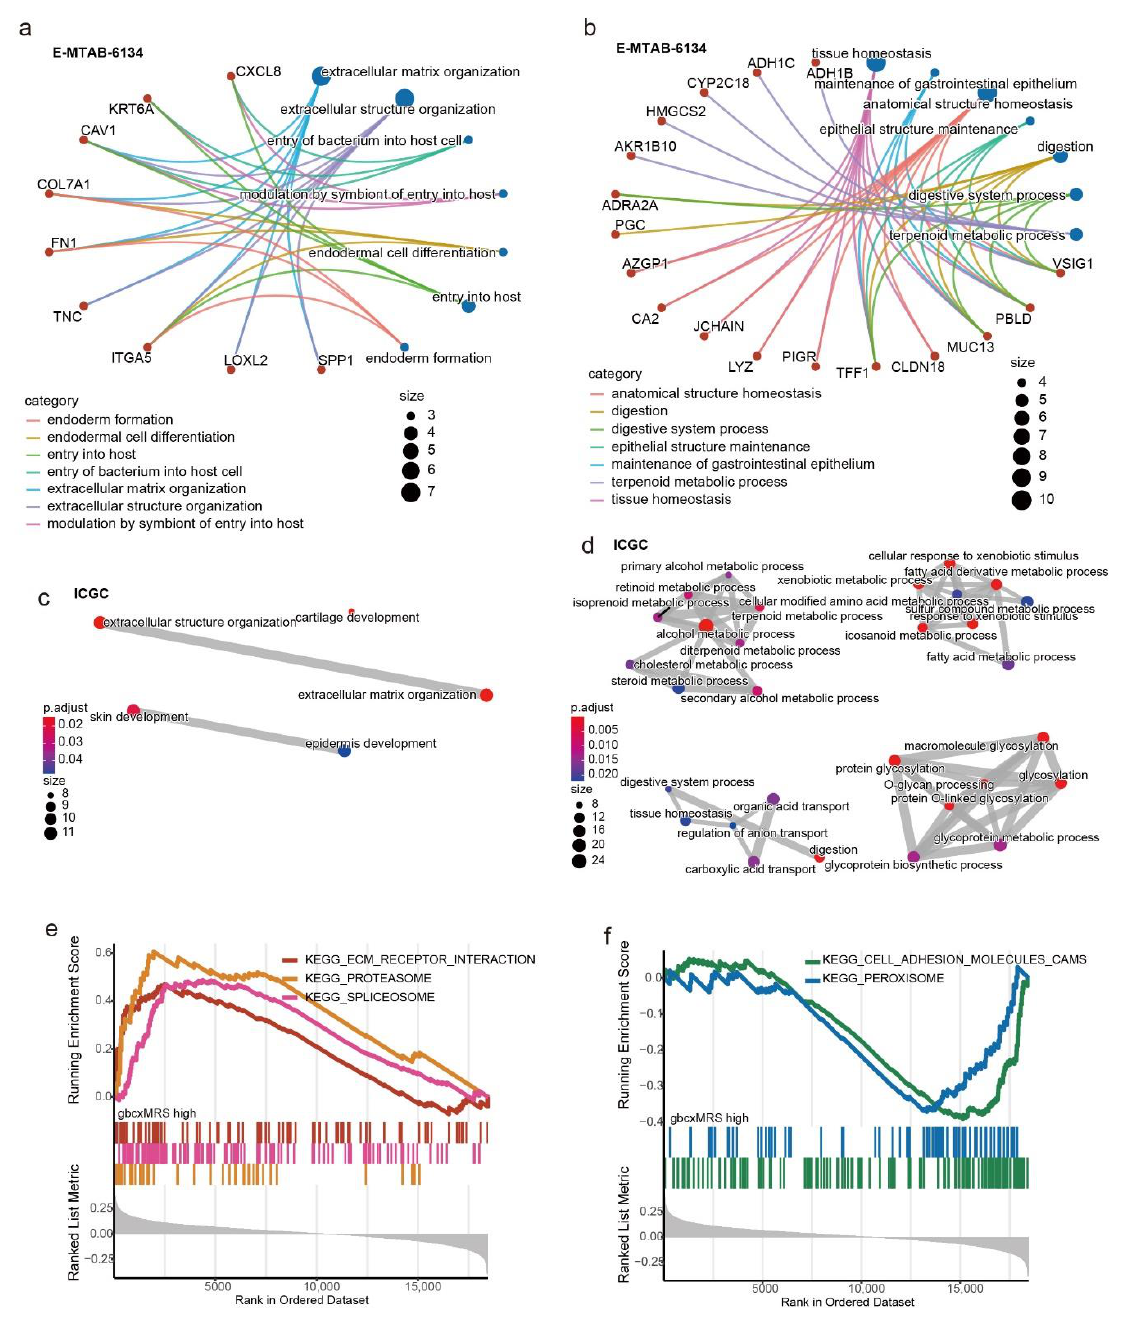
Figure 6. Functional enrichment for the gbcxMRS. ( a , b ) GO analysis of the ( a ) upregulated and ( b ) downregulated genes in the high gbcxMRS patients in the E-MTAB-6134 cohort. ( c , d ) GO analysis of the ( c ) upregulated and ( d ) downregulated genes in the high gbcxMRS patients in the ICGC cohort. ( e ) Pathways activated in the high gbcxMRS group measured by GSEA in E-MTAB-6134. ( f ) Pathways suppressed in the high gbcxMRS group measured by GSEA in